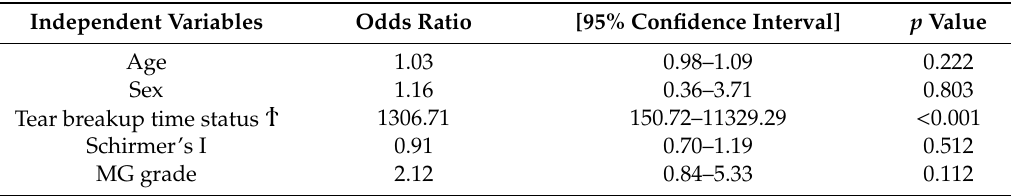
Table 4. Logistic regression with severe dry